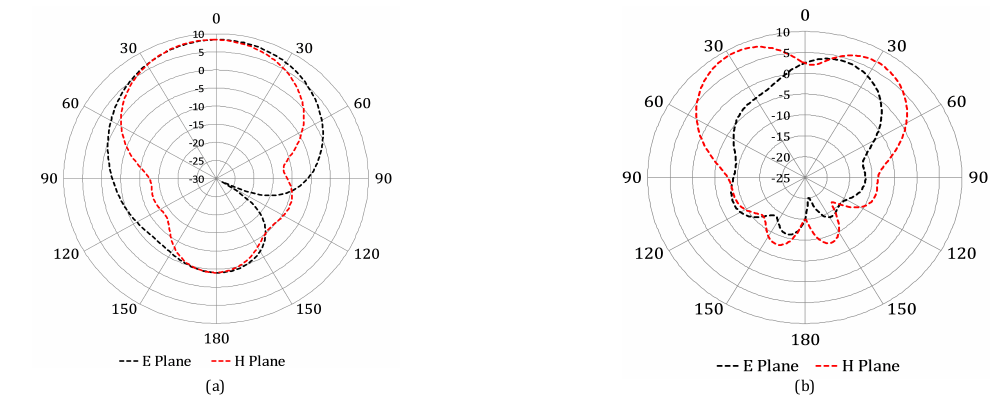
Figure 11. Directivity patterns of conventional dual band antenna at ( a ) 2.5 GHz ( b ) 5.2